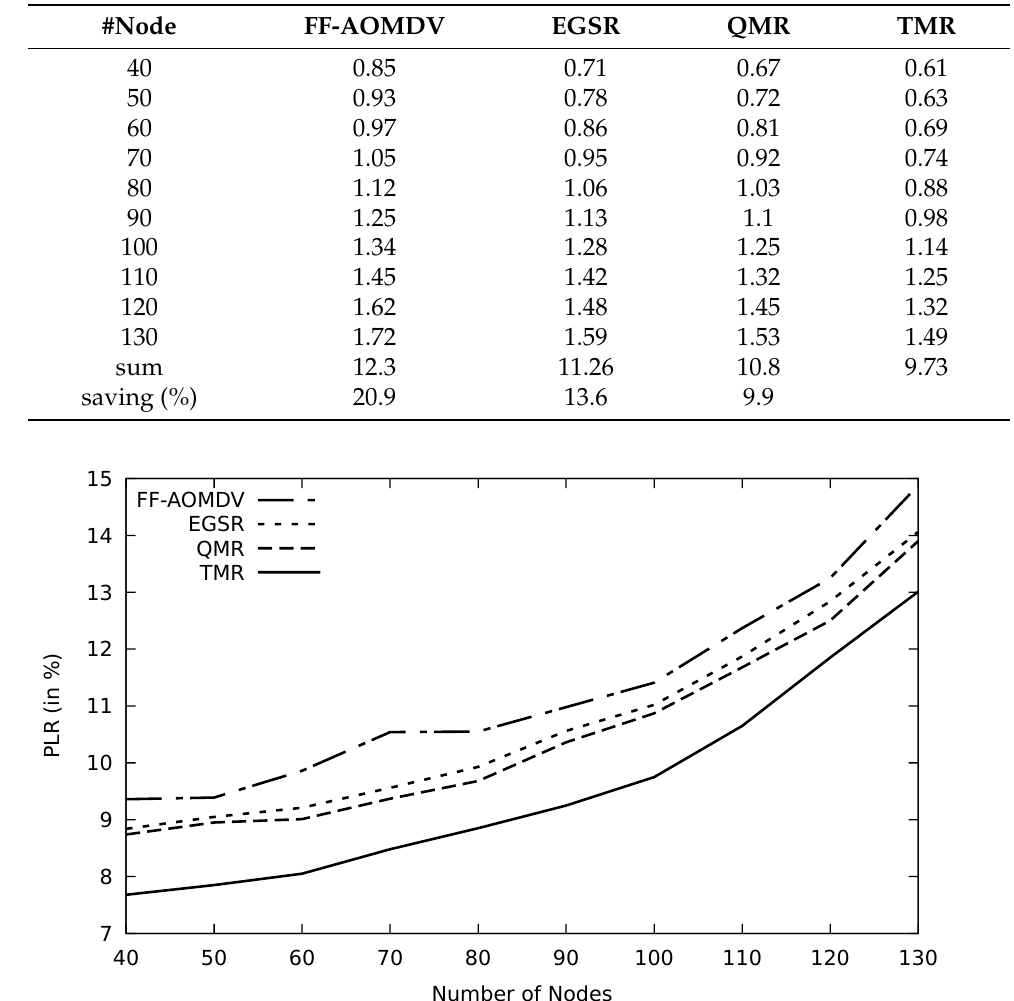
Figure 16. Comparison of FF-AOMDV, EGSR, QMR, and proposed protocol TMR for PLR with number of